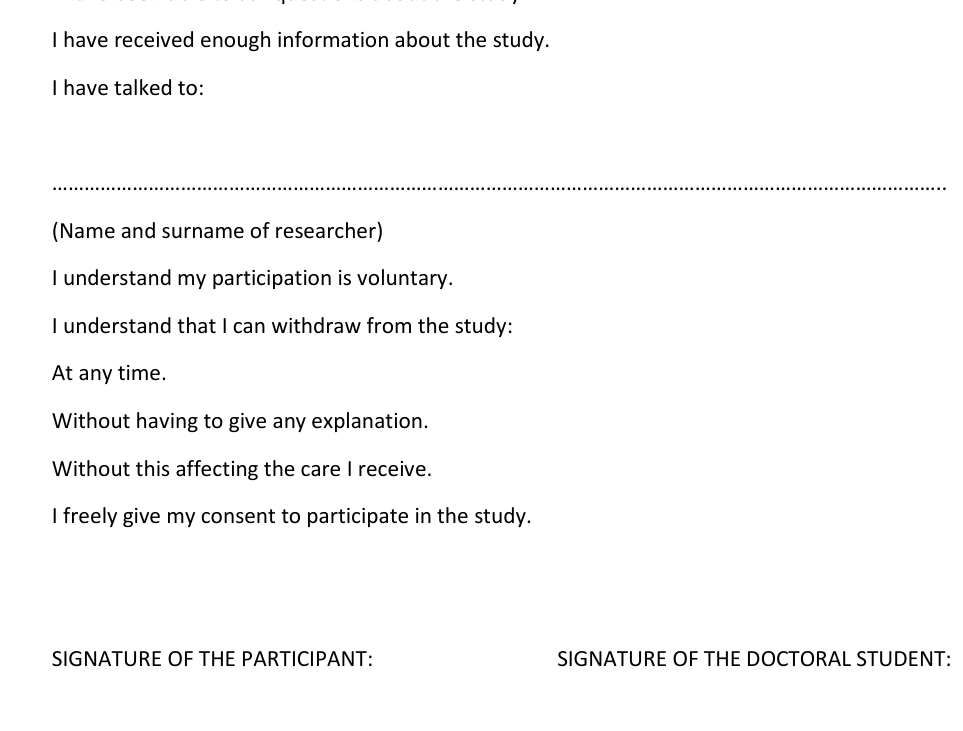
Figure A2. Information Sheet and Informed Consent.